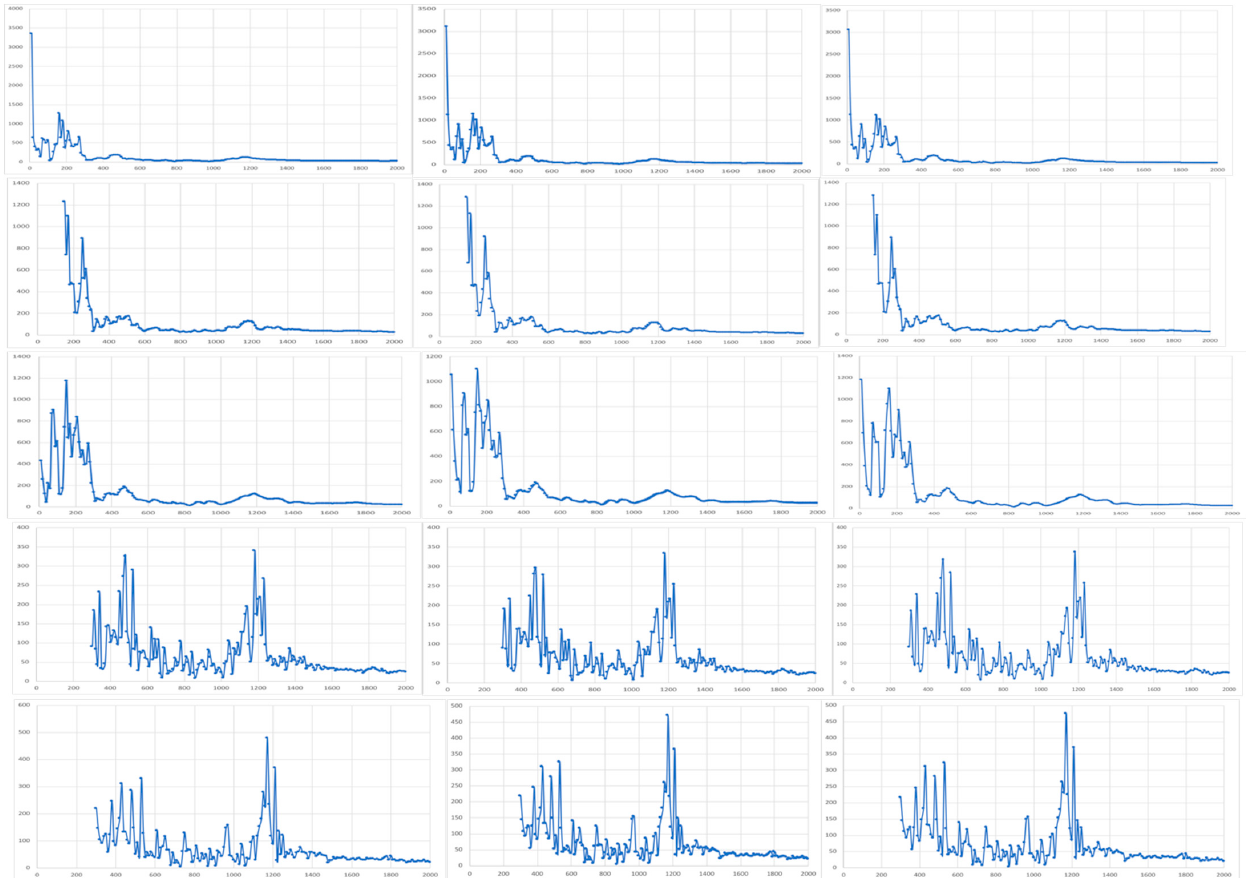
Figure A4. Poled PZT ceramic may be used as a physical unclonable function for secure computing. Five runs in triplicate are shown above, where each sample was a different piece of ceramic. See text for discussion.